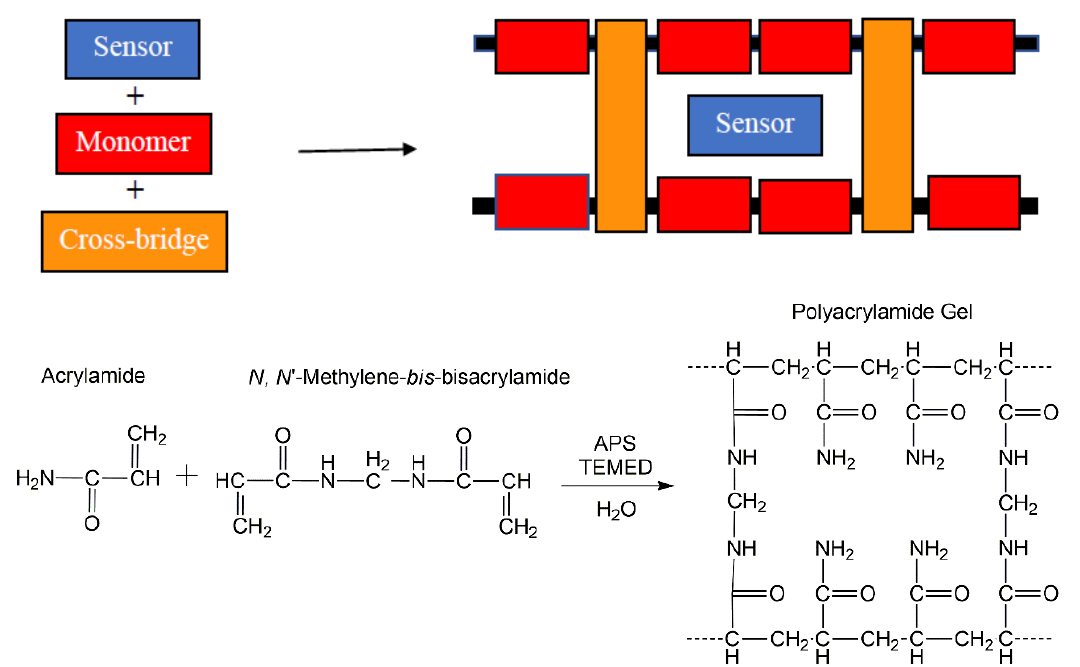
Figure 1. The concept of a sensor (chemosensor, logic gate) encapsulated within a pore of a cross-linked water-compatible polymer matrix ( top ). The polymer is synthesised from acrylamide (monomer) and N , N (cid:48) -methylene- bis -acrylamide (cross-bridge) using APS and TEMED to form the polyacrylamide hydrogel ( bottom